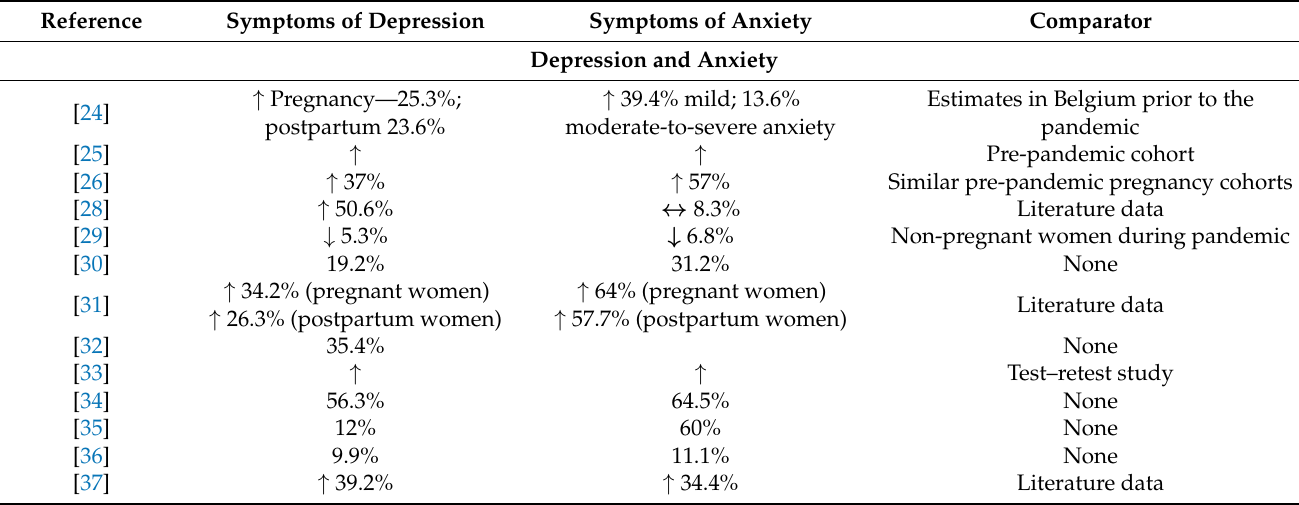
Table 2. Prevalence of depression and